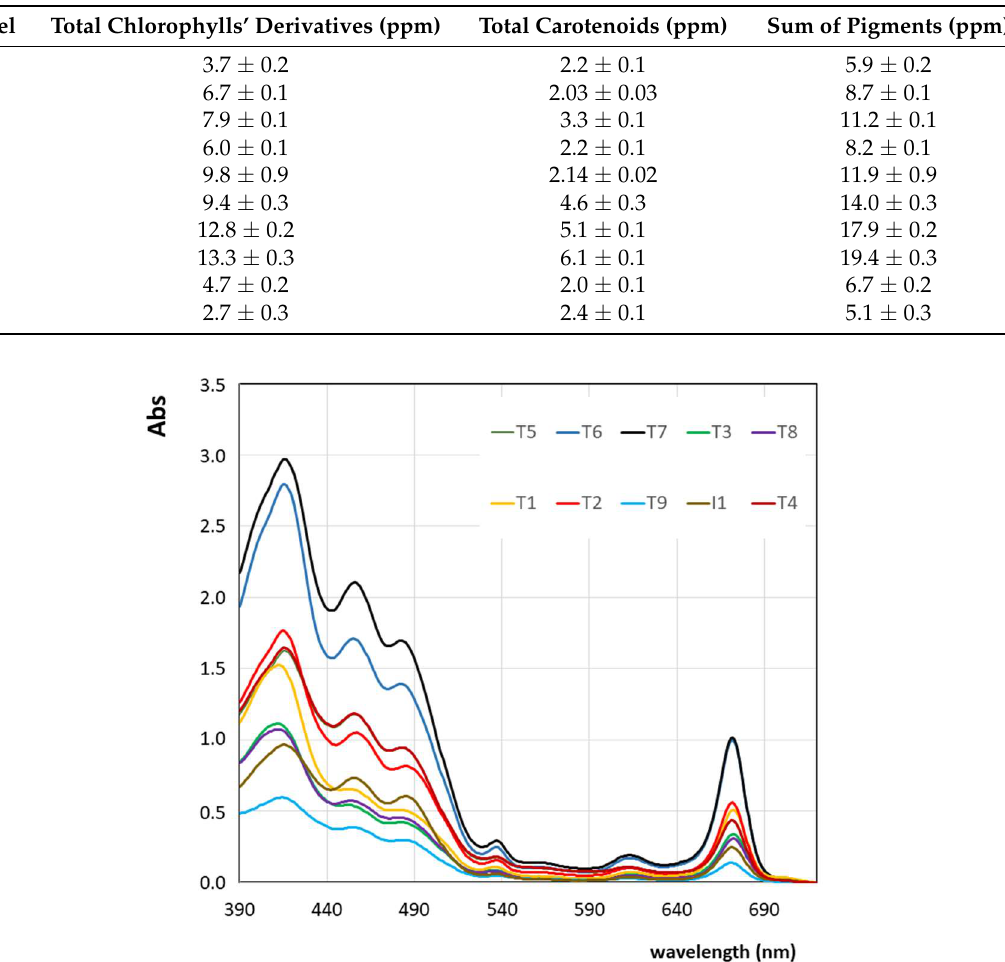
Table 2. Values of total chlorophylls’ derivatives, total carotenoids, and sum of pigments, as determined by the first method (Mínguez-Mosquera et al. [11]). Values are reported as mean ± confidence interval (CI) of three measurements.